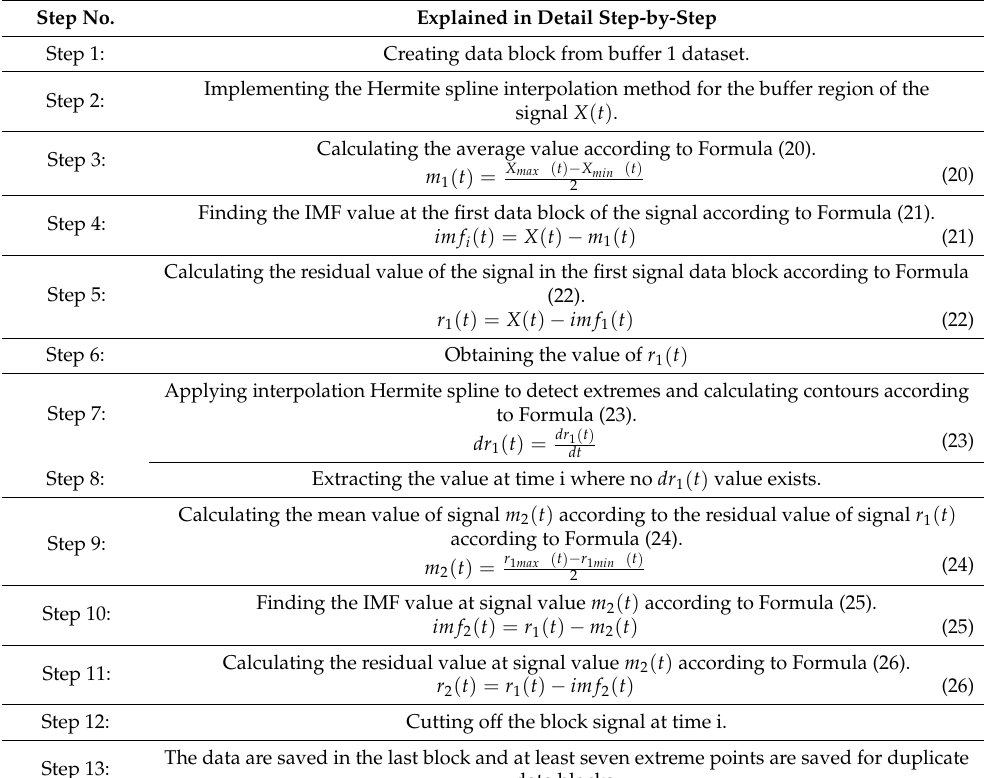
Table 6. The LWEMD